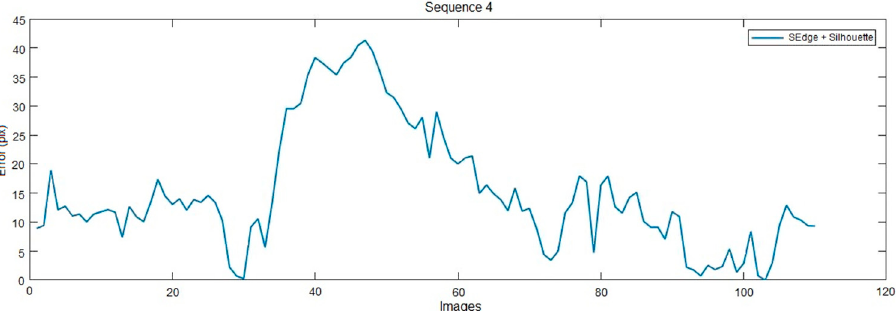
Figure 8. Obtained results on sequence 4 using the combined likelihood function (DS+GG). Average 2D distance between the projected 3D model and the annotated data. This error increases significantly when the tracking of the upper limbs is lost due to self-occlusion, this is the case between frame 40 and 50.